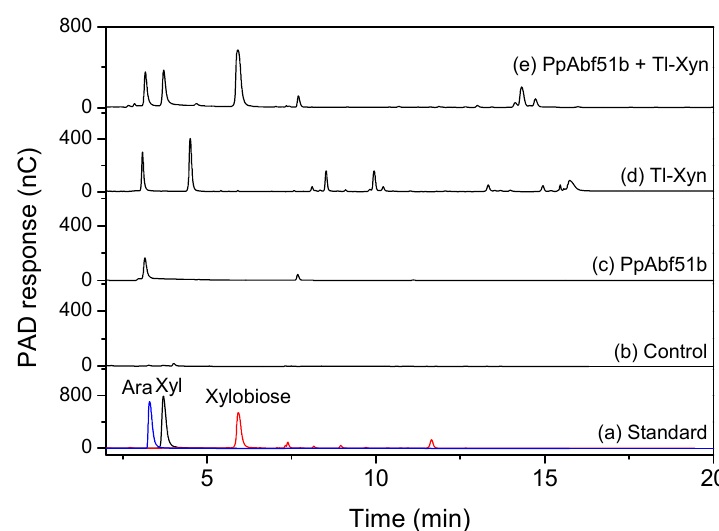
Figure 8. HPAEC analysis of the hydrolysis products of wheat arabinoxylan. ( a ) Standard, arabinose, xylose, and xylobiose; ( b ) Wheat arabinoxylan (control) was hydrolyzed by ( c ) Pp Abf51b; ( d ) Tl-Xyn, or ( e ) the combination of Pp Abf51b and Tl-Xyn. Table 5. Synergistic effect of Pp Abf51b and T. longibrachiatum endo-1, 4- β -Xylanase Tl-Xyn. Enzyme Added